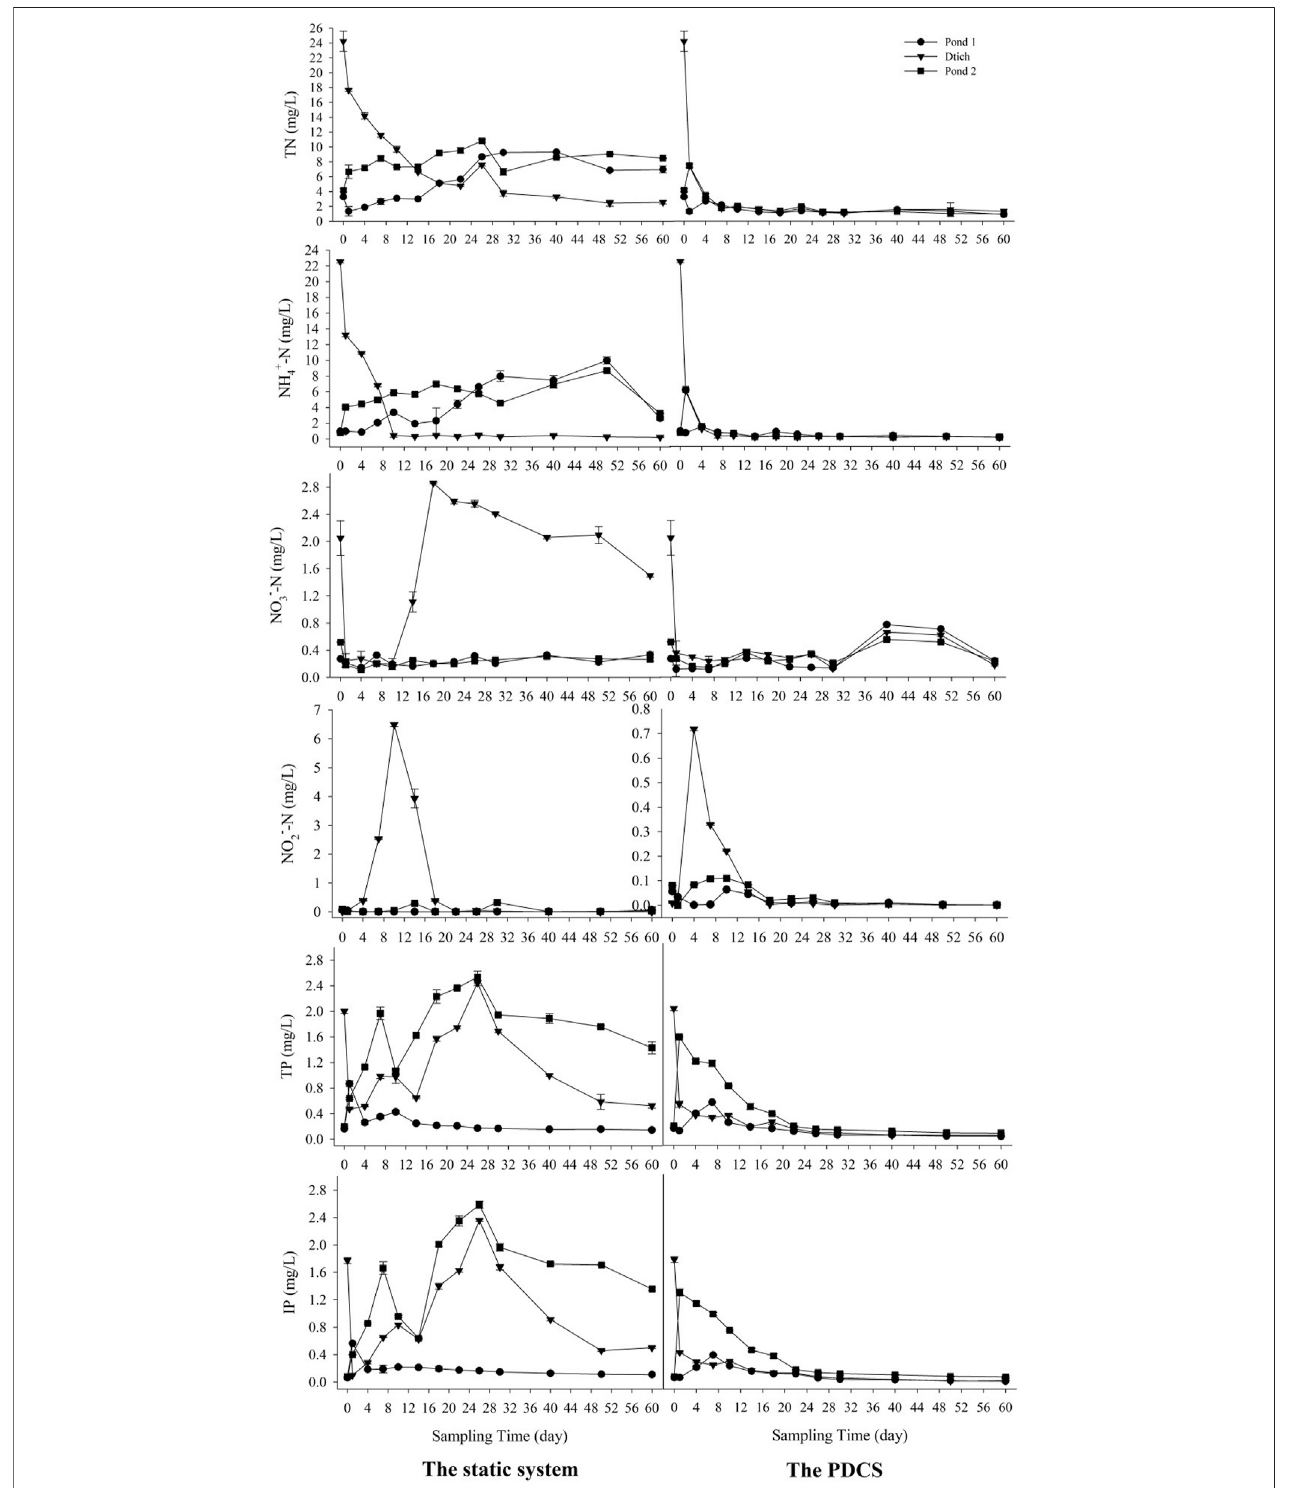
FIGURE2| ChangesofTN,NH 4+ -N,NO 3 − -N,NO 2 − -N,TP,and IPinoverlyingwaterfortwosystems within60samplingdays.In thecirculation PDCS system, the water was circulated 3.6 L/h every other 4 h, while the control group was static.